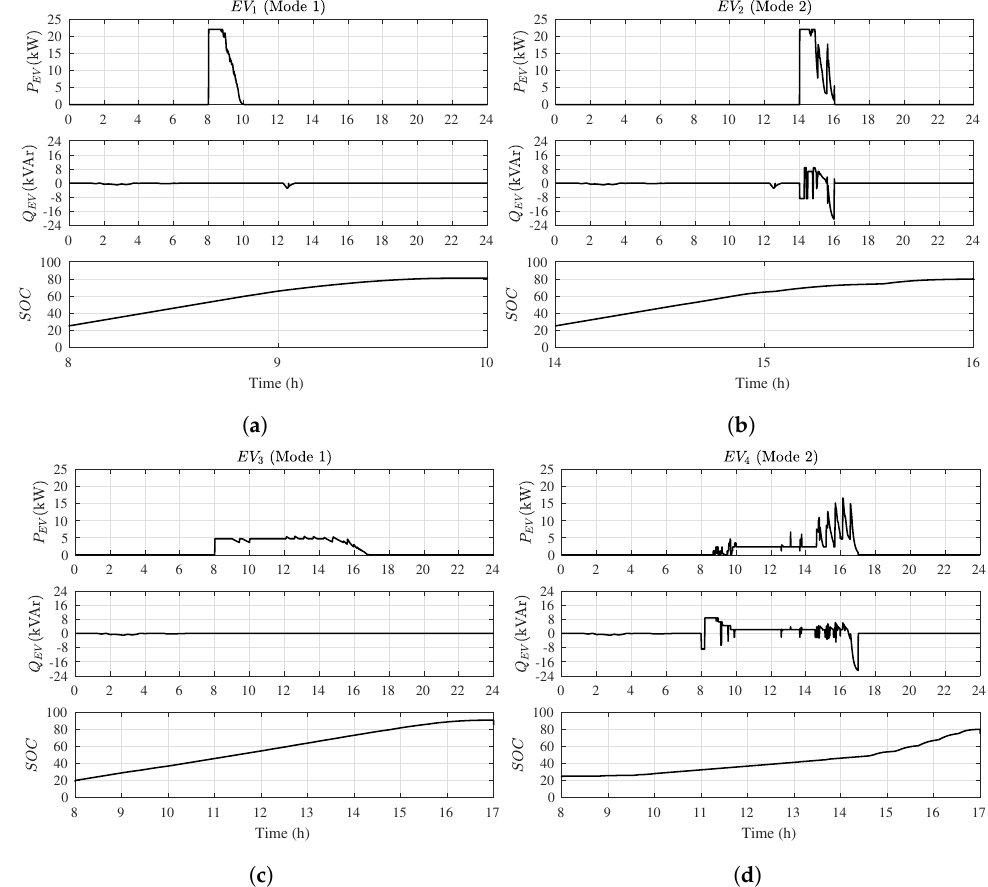
Figure 13. Active and reactive reference profiles and SOC of each vehicle in the scenario 2: ( a ) EV 1 , ( b ) EV 2 , ( c ) EV 3 and ( d ) EV 4